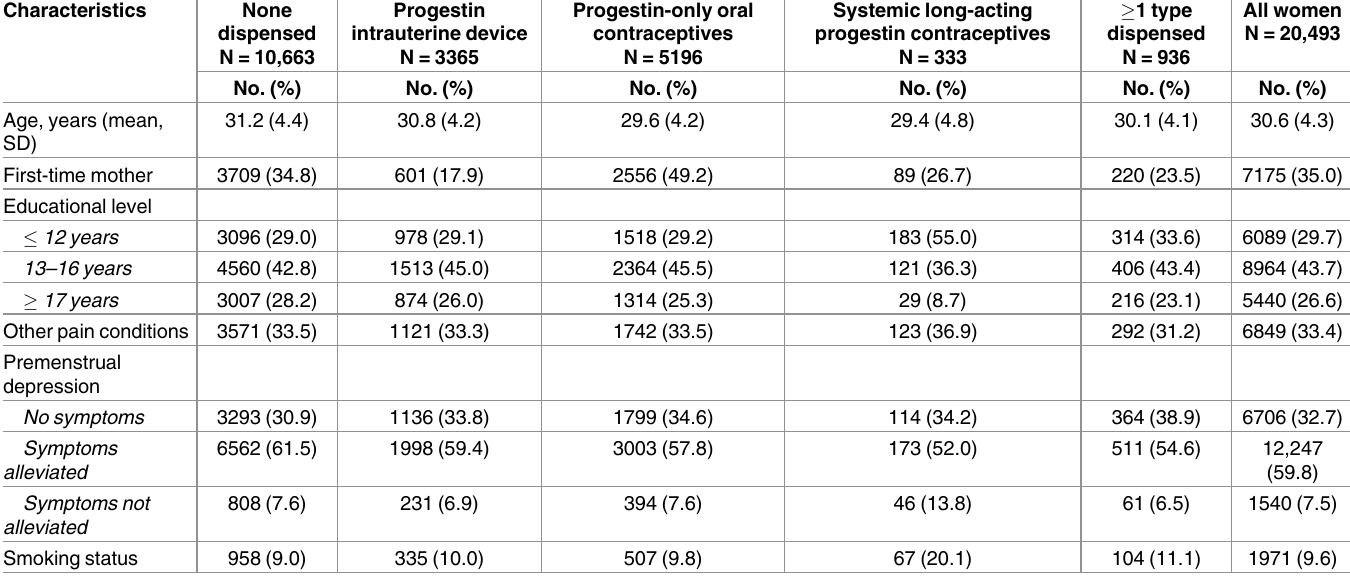
Table 1. Characteristics of the study sample by dispense of progestin-only contraceptives (N = 20,493).